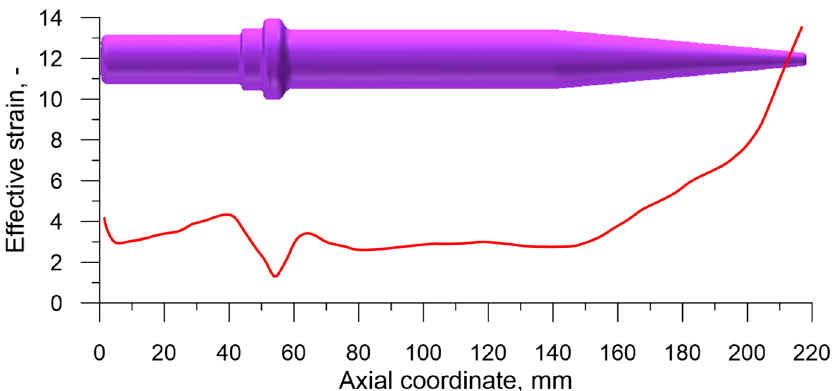
Figure 18. Distribution of the effective strain in the axis of the rolled preform.